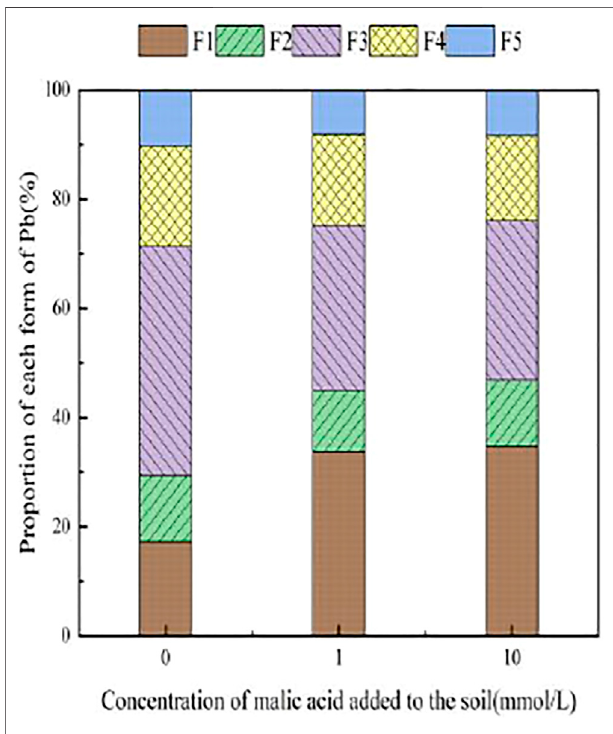
FIGURE 10 | Distribution of Pb form in